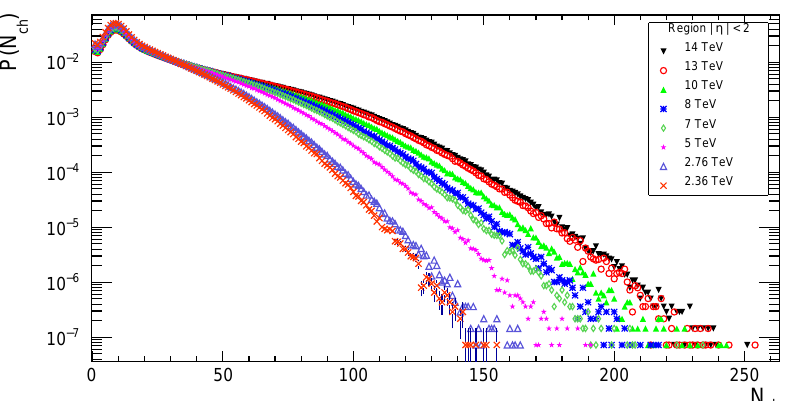
Figure 3. The charged particle multiplicity distribution in the pseudorapidity interval | η | < 1.5, with p T > 0.1.